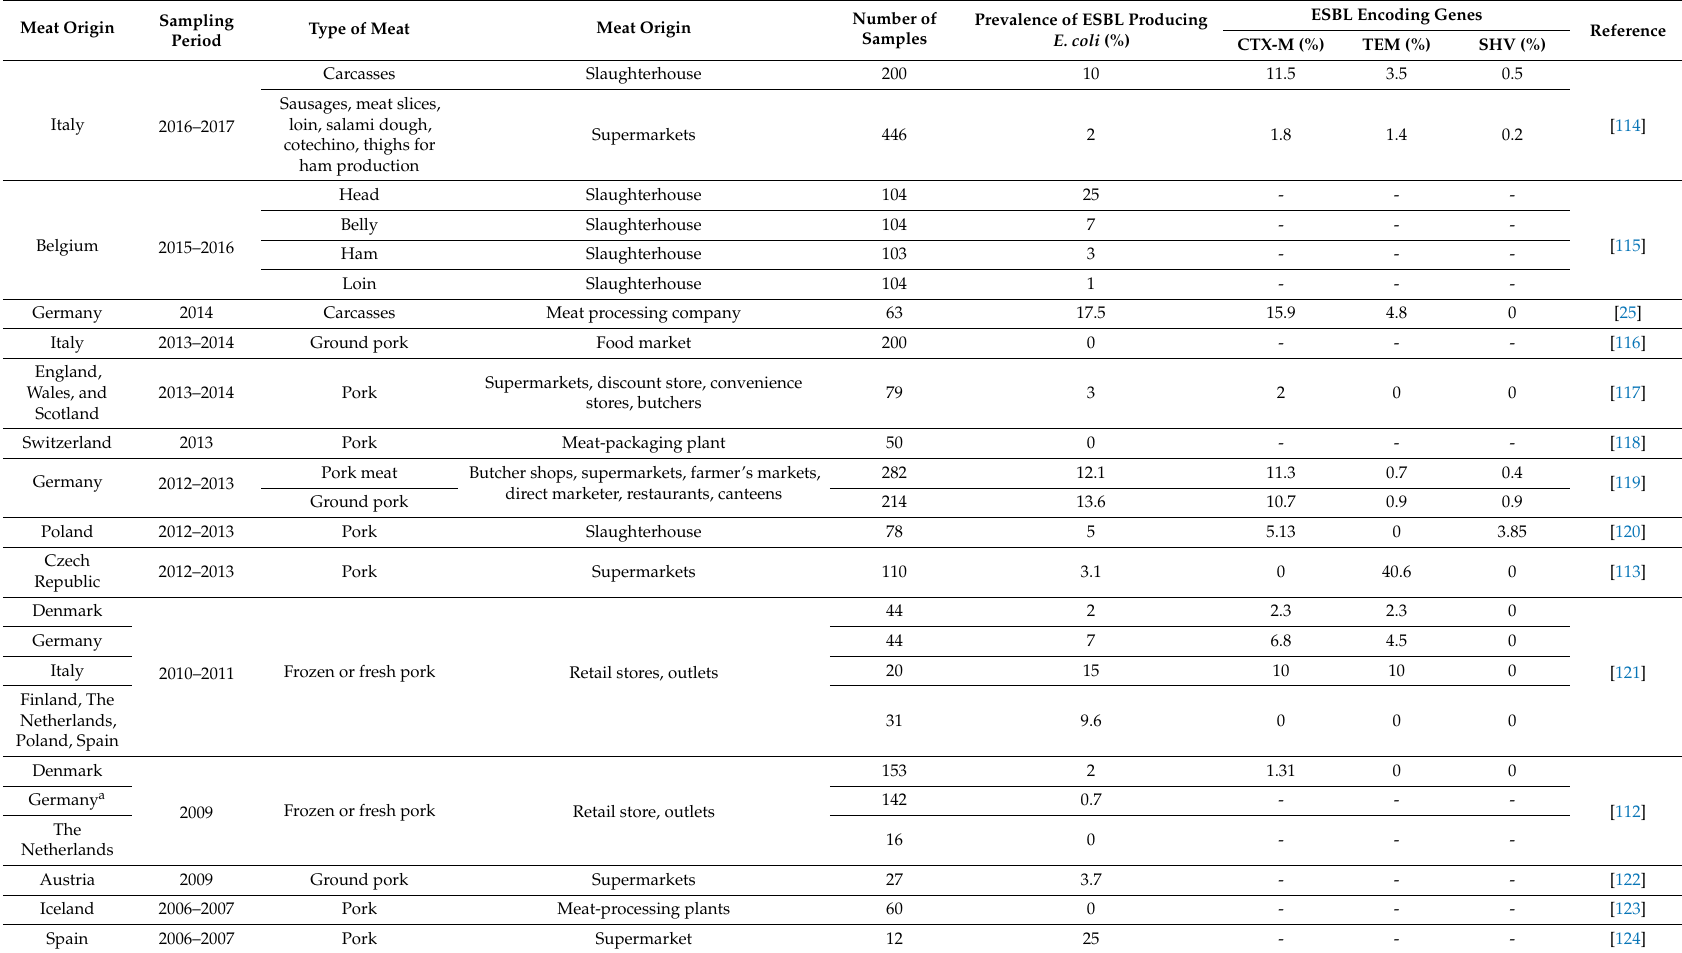
Table 6. Prevalence of ESBL producing E. coli in pork meat, obtained from studies published in the